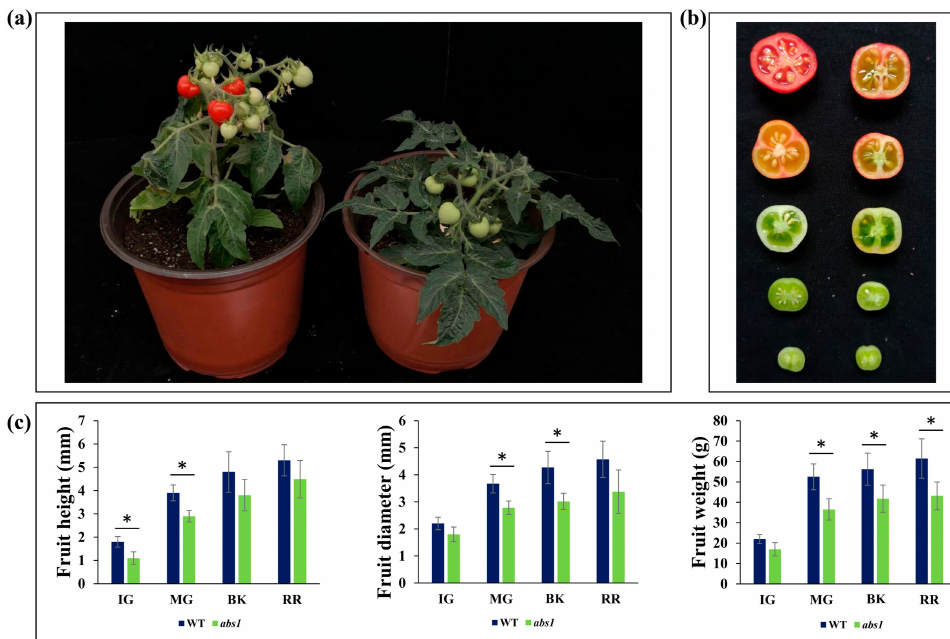
Figure 4. Characterization of morphological traits of abs1 mutant and WT fruits. ( a ) The visual appearance of WT ( left ) and abs1 plants ( right ). ( b ) The visual appearance of WT ( left ) and abs1 fruits ( right ) at different maturity stages. ( c ) Average fruit height, fruit diameter, and fruit weight for WT fruit and abs1 fruit. The error bar represents standard error. Asterisks indicate significant differences (*: p ≤ 0.05, Student’s t